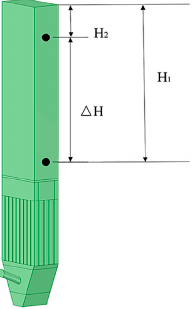
Figure 2. Schematic diagram of the concentration detection principle.